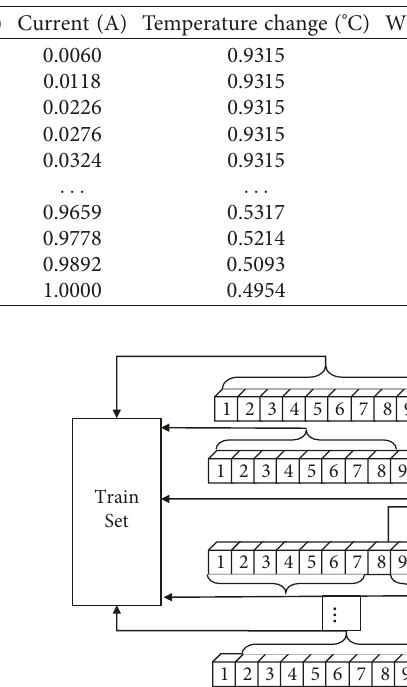
Table 3: Expanded and normalized sample data.